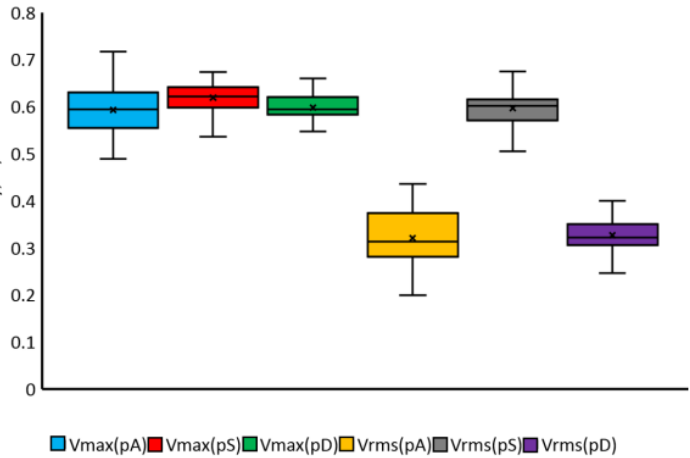
Figure 18. Summary of the maximal velocity and RMS velocity values obtained during tests of precise hand movement.